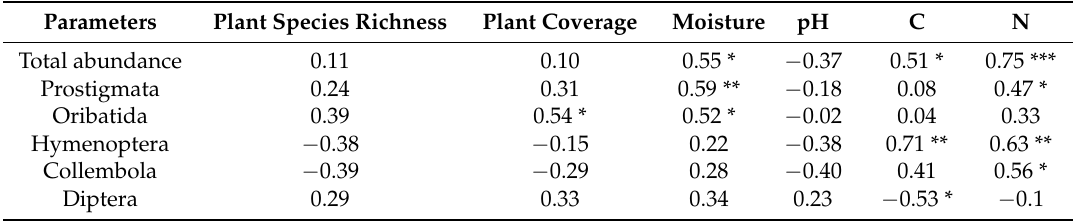
Table 5. Correlation between abundance of soil arthropods and soil characteristics. Values are Spearman correlation